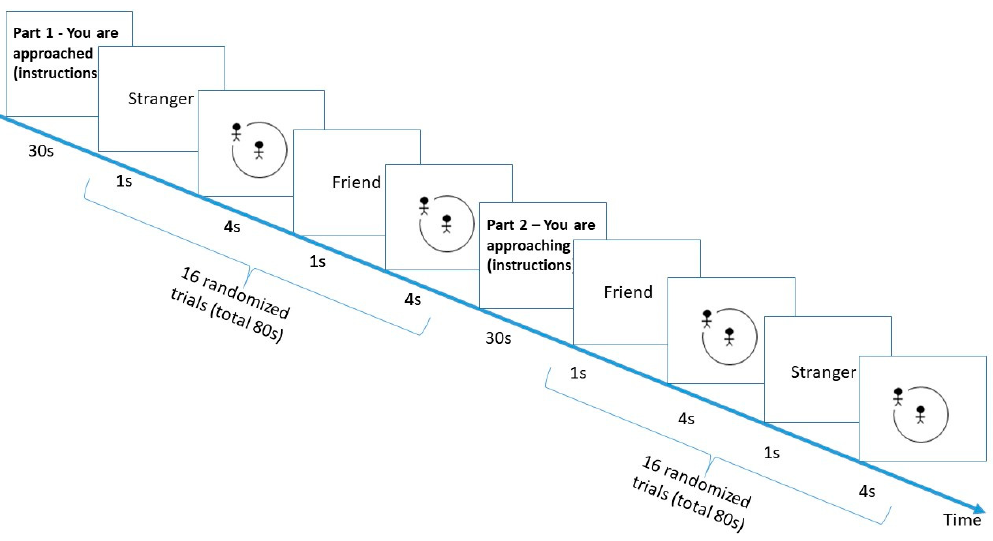
Figure 1. Interpersonal distance task.